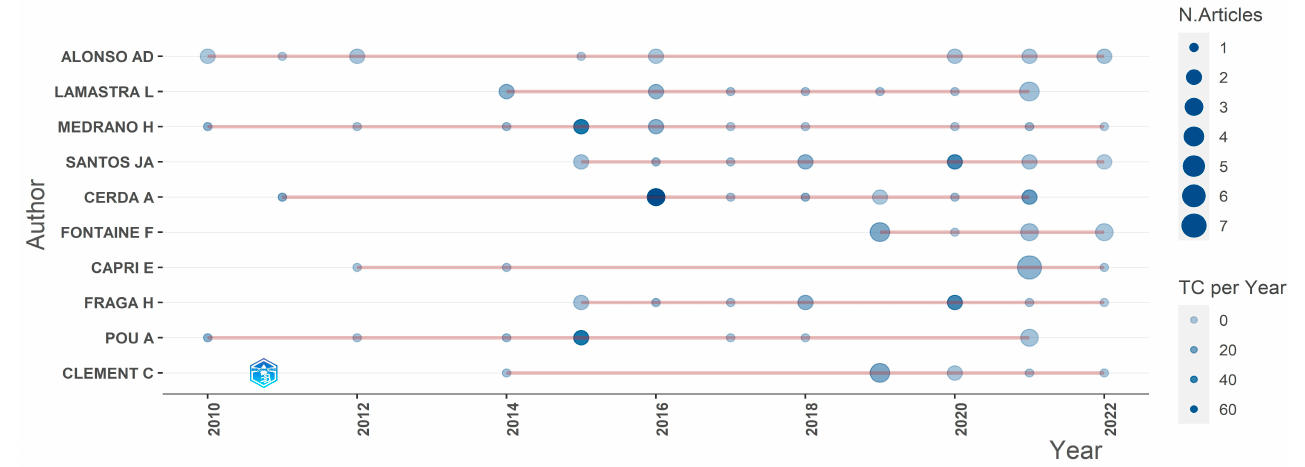
Figure 5. Evolution of the leading authors’ scienti fi c production. Note: TC means Total citations.